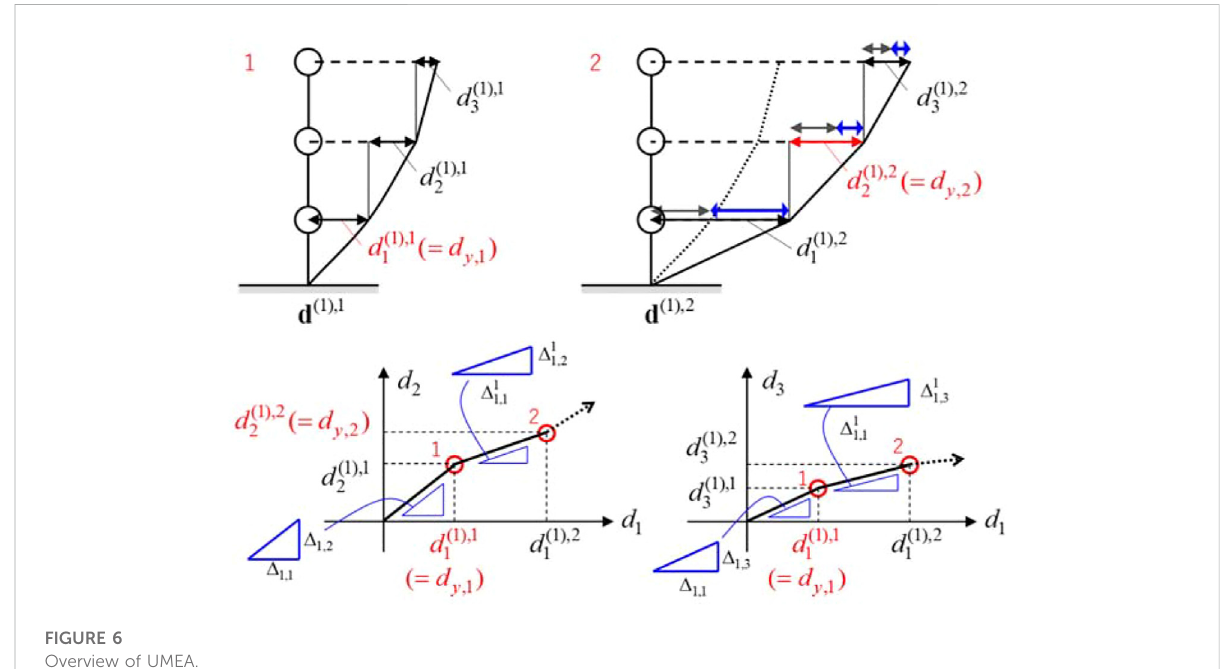
FIGURE 6 Overview of